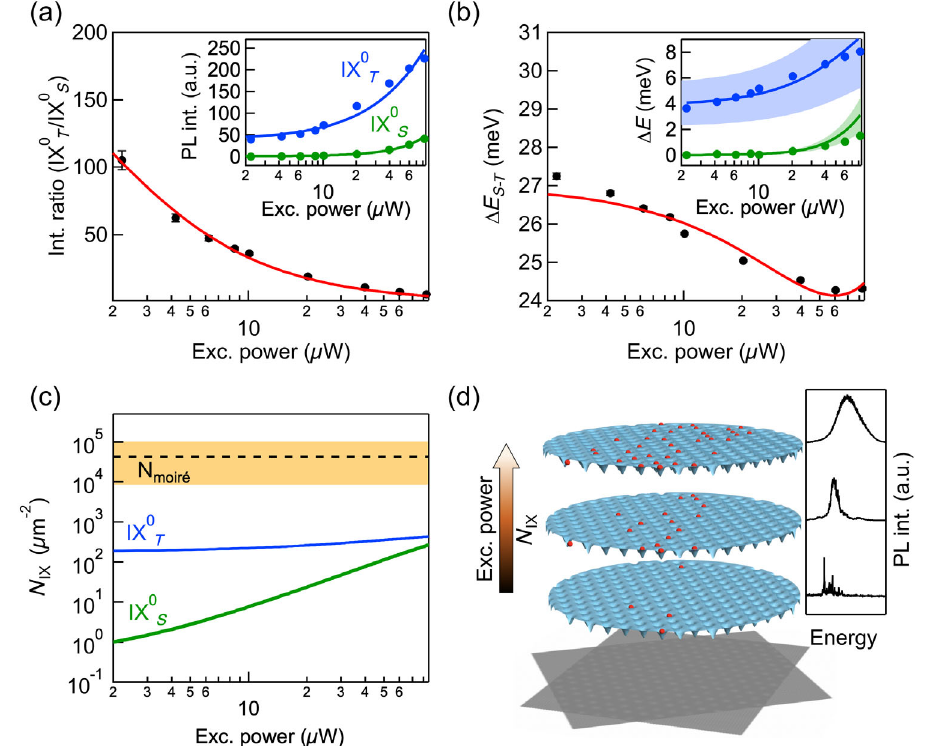
FIG. 2. Dipolar interactions of an ensemble of trapped IXs. (a) Ratio of integrated PL intensities between the IX 0 and IX 0 peaks T S /IX 0 ) as a function of P extracted from Fig. 1(b) (black dots). The inset shows the evolution of the integrated PL intensities for (IX 0 exc T S each individual peak in the same P range. The red, blue, and green solid lines represent fits of the experimental data to the rate exc and IX 0 ( Δ E ) as a function of the equation model described in the Supplemental Material [38]. (b) Energy splitting between IX 0 S − T T S excitation power (black dots). The inset shows the energy shifts of the individual peaks. The red solid line represents a fit of the experimental Δ E to Eq. (2), while the green and blue solid lines are fits of the measured Δ E to Eq. (1), and the shaded areas S − T S;T represent the uncertainty interval corresponding to d values ranging from 0.4 [8] to 1 nm [55]. (c) Estimated power-dependent densities of IXs with spin-singlet (green) and spin-triplet (blue) configurations. The thickness of the lines indicates the confidence interval estimated from the fits to the experimental data. The black dashed line indicates the density of moir´e traps estimated for our heterostructure, while the orange shaded area represents the density of sites for MoSe 2 = WSe 2 heterobilayers with stacking angles between 54.4° and 58.4°. (d) Sketch depicting the transition between the low- and high-excitation power regimes for IXs (red spheres) trapped in the moir´e sites of a MoSe 2 = WSe 2 heterobilayer. At low P , only a few IXs are a localized in the moir´e sites lying inside the exc circular confocal collection spot (not to scale). As P increases, more and more optically generated IXs are trapped in the moir´e sites, exc giving rise to a broad PL emission band originating from an ensemble of moir´e-trapped IXs. Even at the highest P used in this work, exc less than approximately 2% of moir´e sites contain trapped